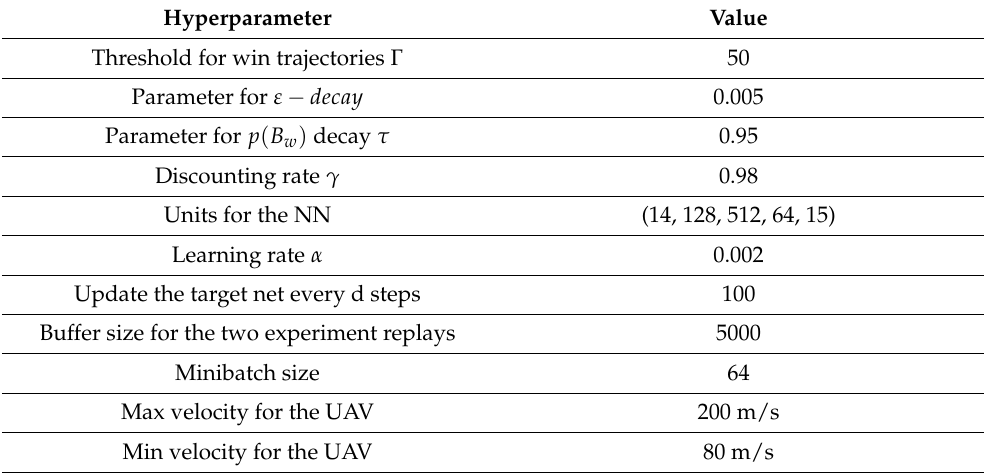
Table 2. Hyperparameters of the experiment.